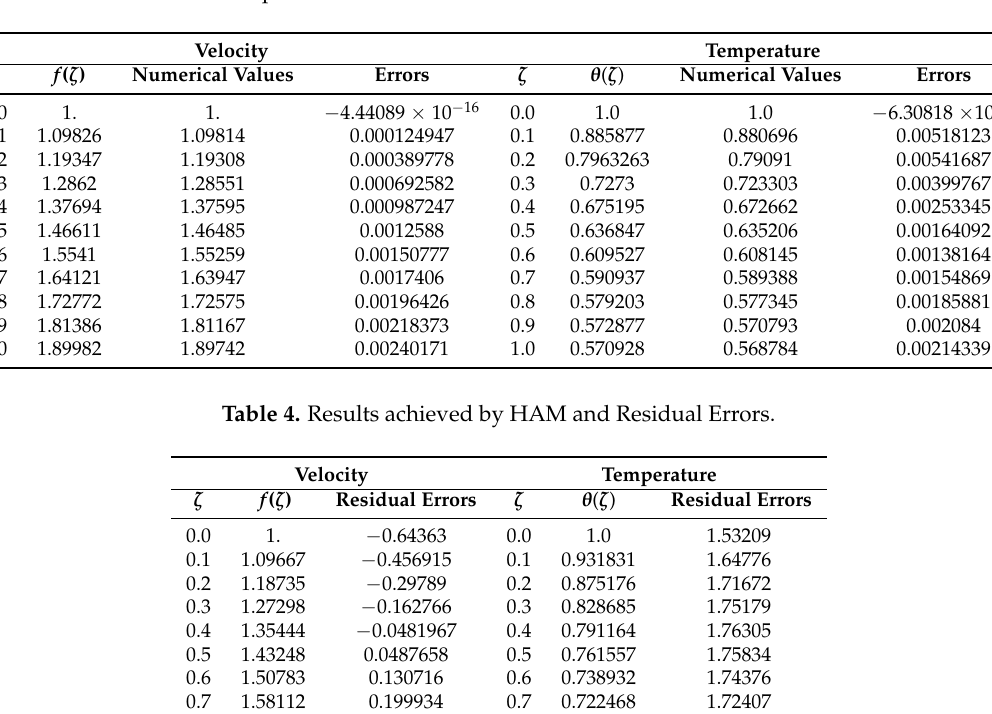
Figure 21. Residual errors sketch of the temperature solution of HAM when β 1 = 2.00, M = 0.10, Re = 0.70, φ = 0.04, Pr = 1.10 and various values of h for (CuO-H 2 O). Table 3. Comparison of solution of HAM with numerical method solution.